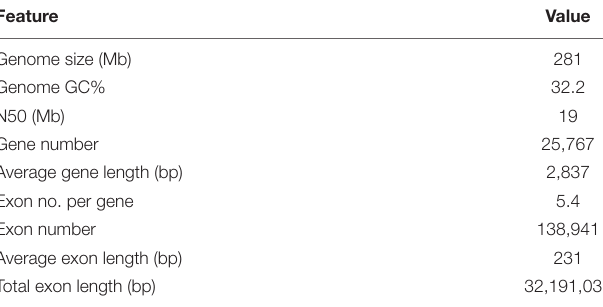
TABLE 1 | Statistics of the A. indica genome